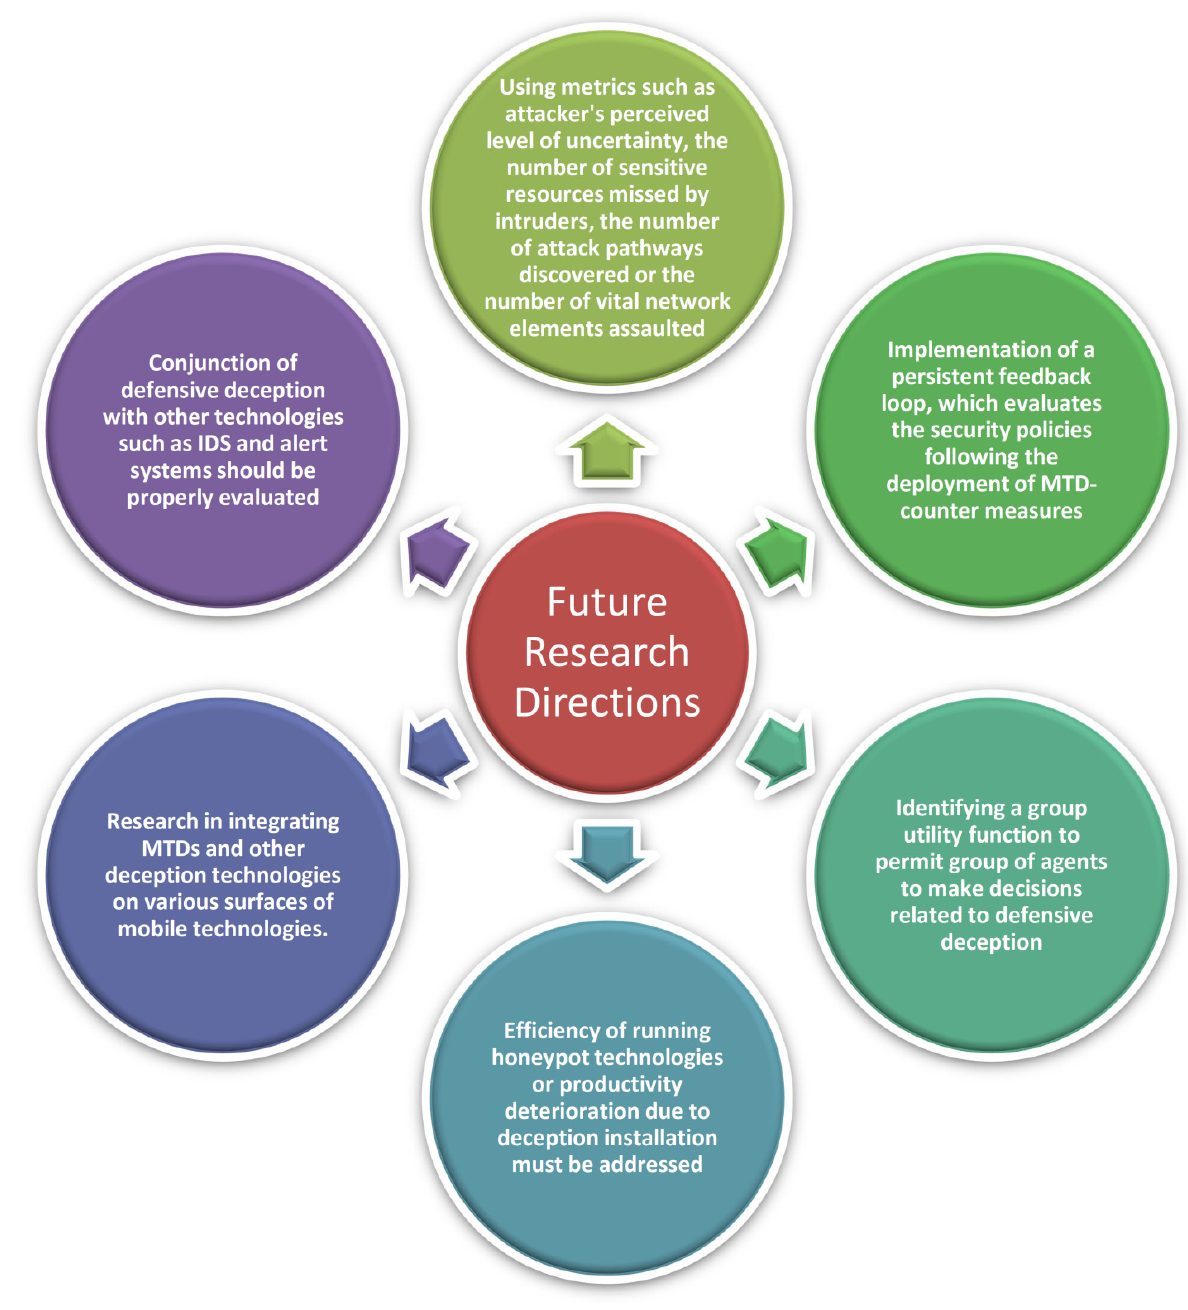
Figure 6. Future directions in Defensive